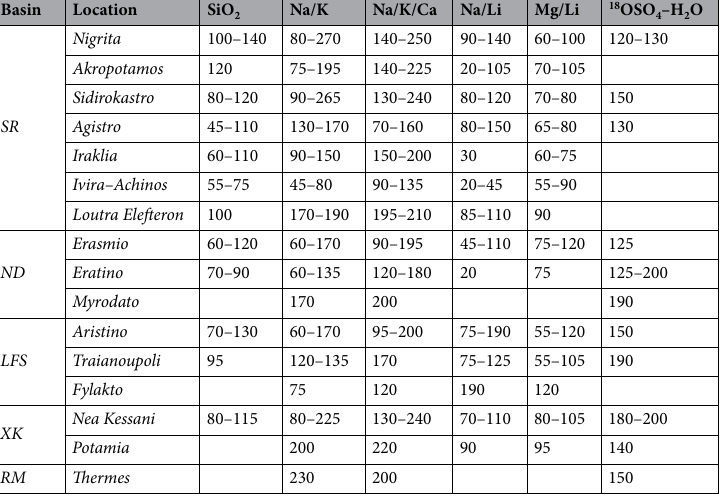
Table 1. Reservoir temperatures, as calculated from